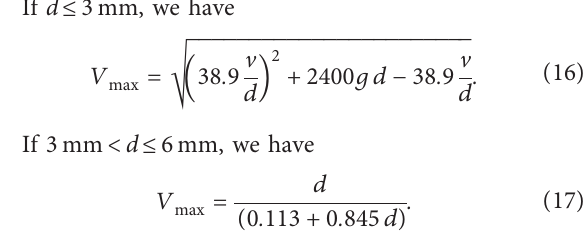
and infiltration [20, 21].